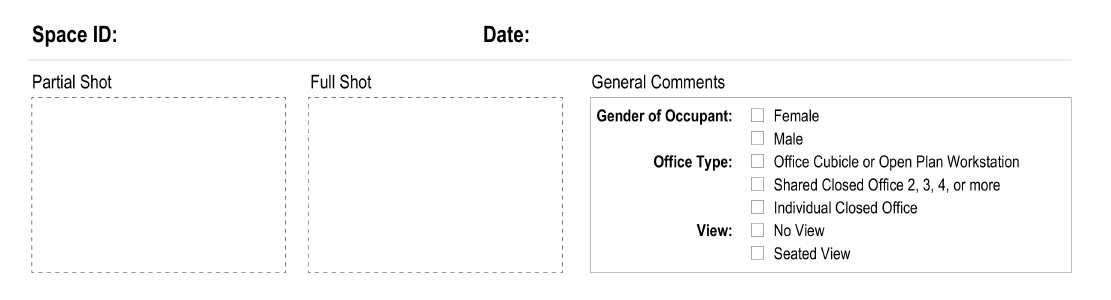
Figure A2. Workstation data